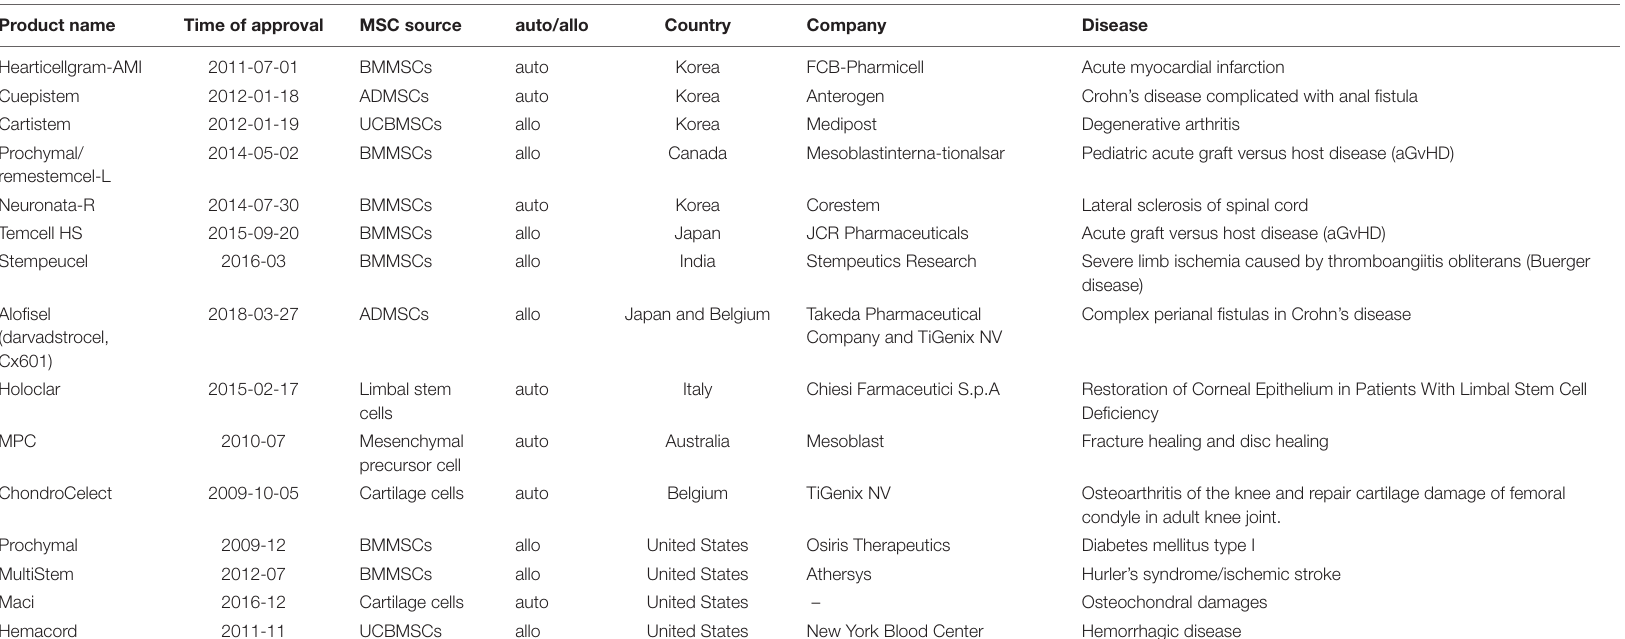
TABLE 1 | Approved MSC-based medicinal